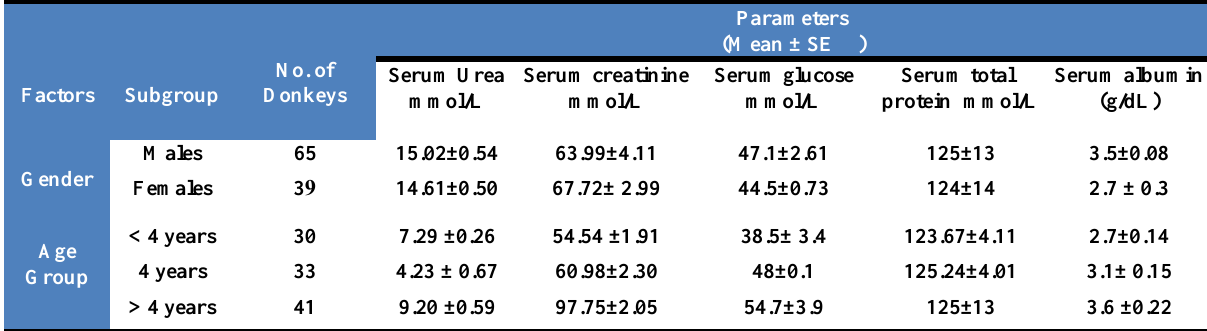
Table, 2: Serum creatinine, urea, glucose, total protein and albumin concentrations expressed according to sex, and age factors (Mean ±